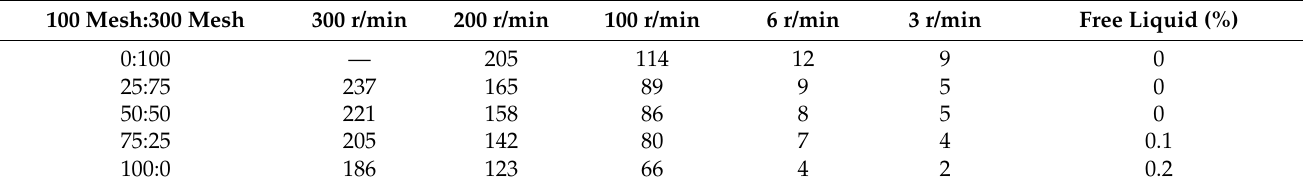
Table 3. Effect of composite silica fume on the rheology and free liquid of cement slurry.